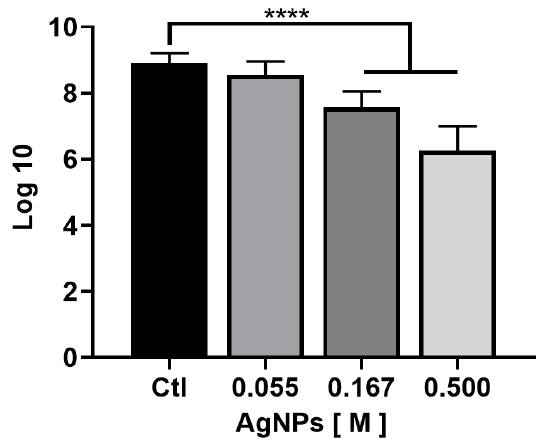
Figure 7. Radiosterilized porcine skin electrosprayed with silver nanoparticles inhibits Pseudomonas aeruginosa biofilm formation. Treatment with RPS at 0.167 and 0.500 M of AgNPs significantly inhibits the Pseudomonas aeruginosa biofilm formation; **** p < 0.0001. Results are expressed as the mean plus or minus SD of three independent experiments.